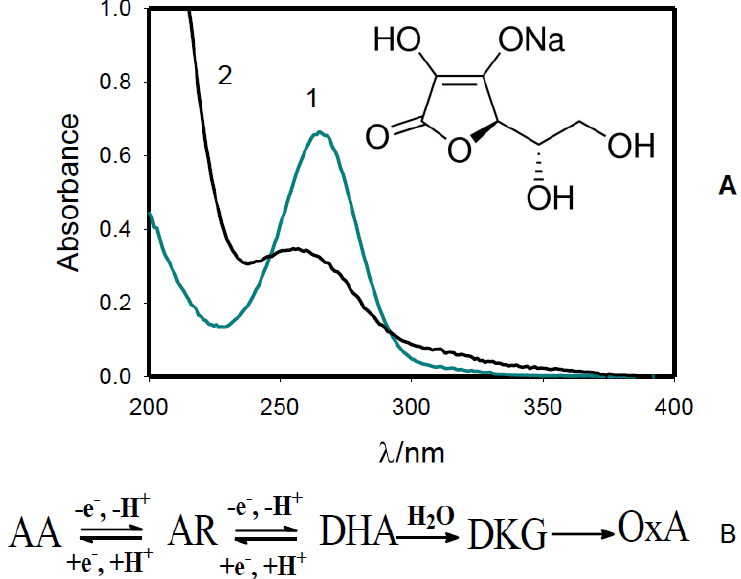
Figure 6. ( A ) Absorption spectra of 0.25 mM sodium ascorbate aqueous solution before (1) and after treatment with cold atmospheric pressure He-plasma jet for 30 min (2). ( B ) Oxidation, hydrolysis, and decomposition processes of sodium ascorbate.